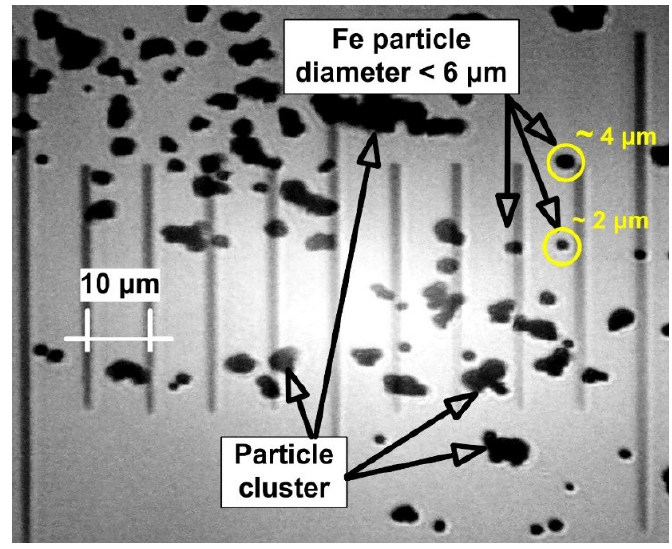
Figure 2. Morphology of the 4–6 μm Fe powder as seen in a microscopic picture.